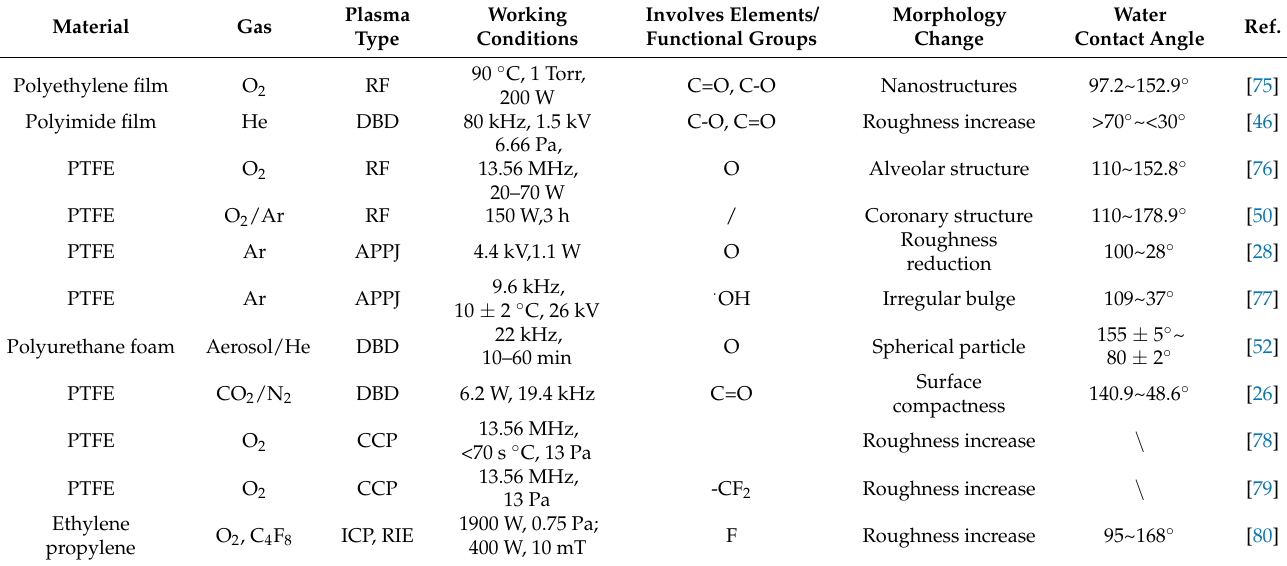
Table 3. Plasma surface treatment of polymer.